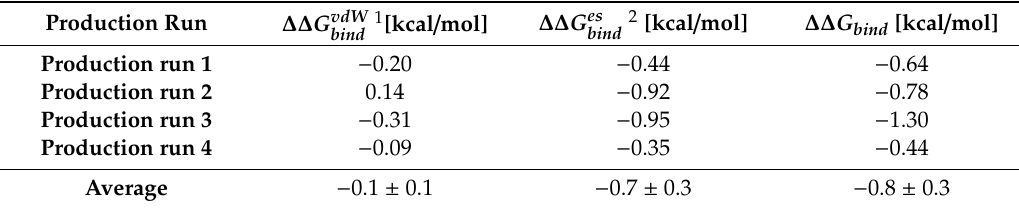
Table 1. The free energy di ff erences ∆∆ G bind between the complex containing rSNP rs35126805 and the wild-type DNA sequence for all production runs along with their electrostatic and van der Waals